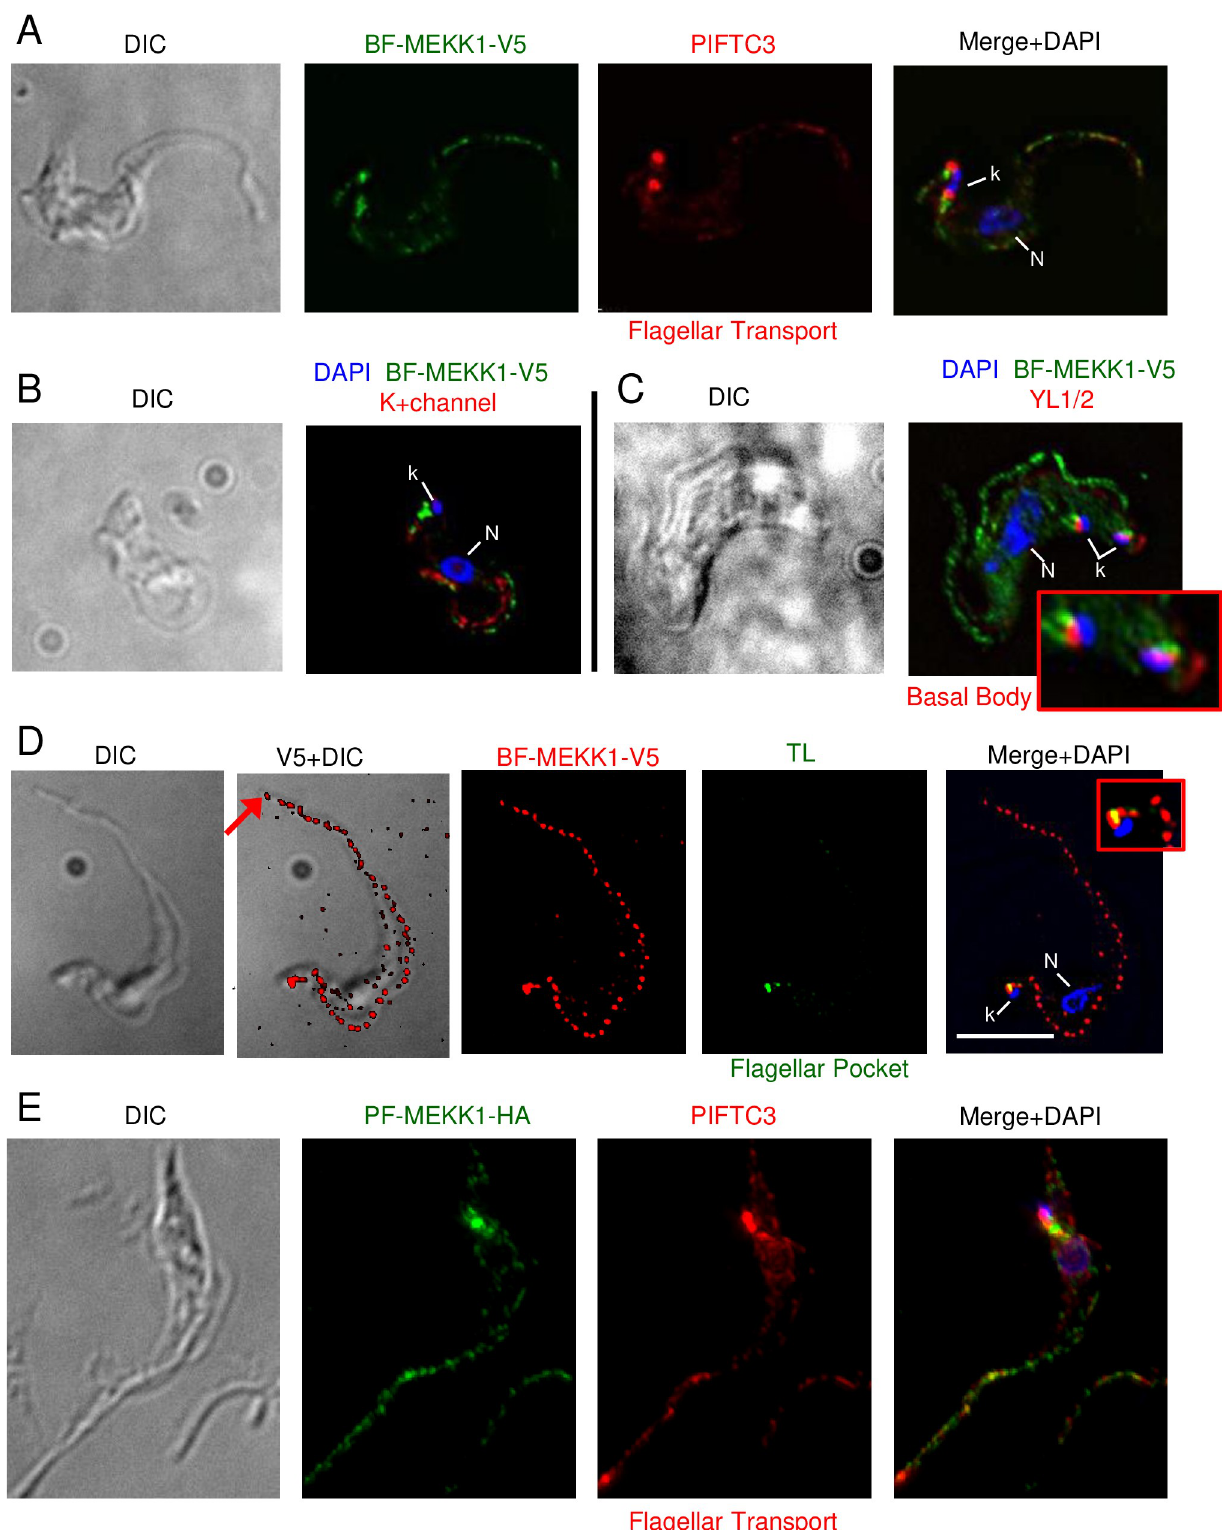
Fig 5. Immunofluorescence localization of MEKK1-V5 (Tb927.2.2720) in T . brucei . A) Co-staining of BF with antibody to T . brucei PIFCT3 (red) [26], a component of the flagellar transport system. B) Co-staining of BF with antibody to a K+ channel protein that colocalizes with the flagellar